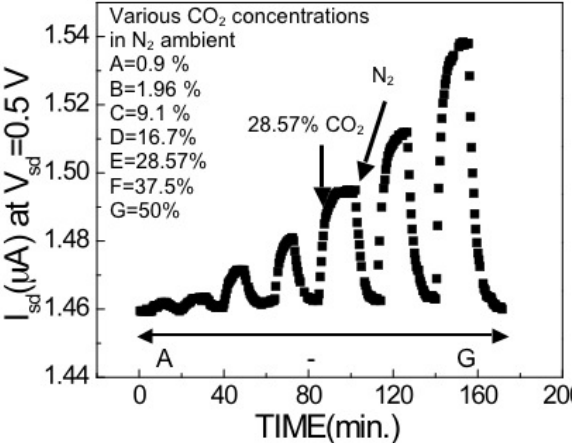
Figure 15. Drain current of PEI/starch functionalized HEMT sensor measured at fixed source-drain during the exposure to different CO voltage was 0.5 V and measurements were conducted at 108 o